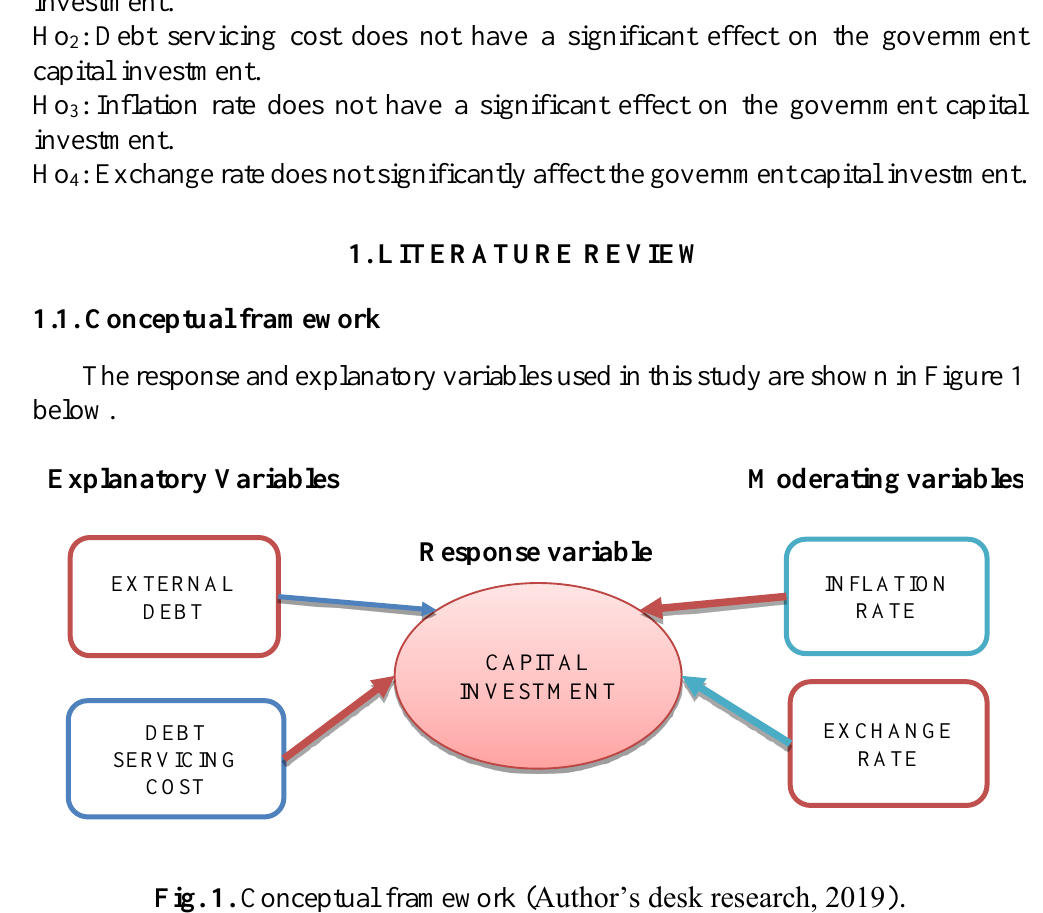
Fig. 1. Conceptual framework (Author’s desk research,